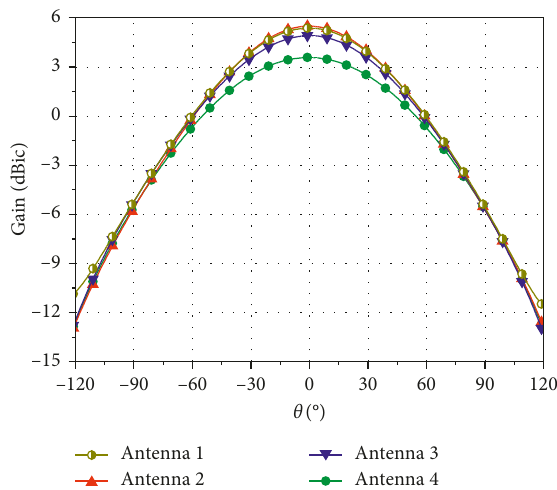
Figure 3: Radiation patterns for different antenna structures at